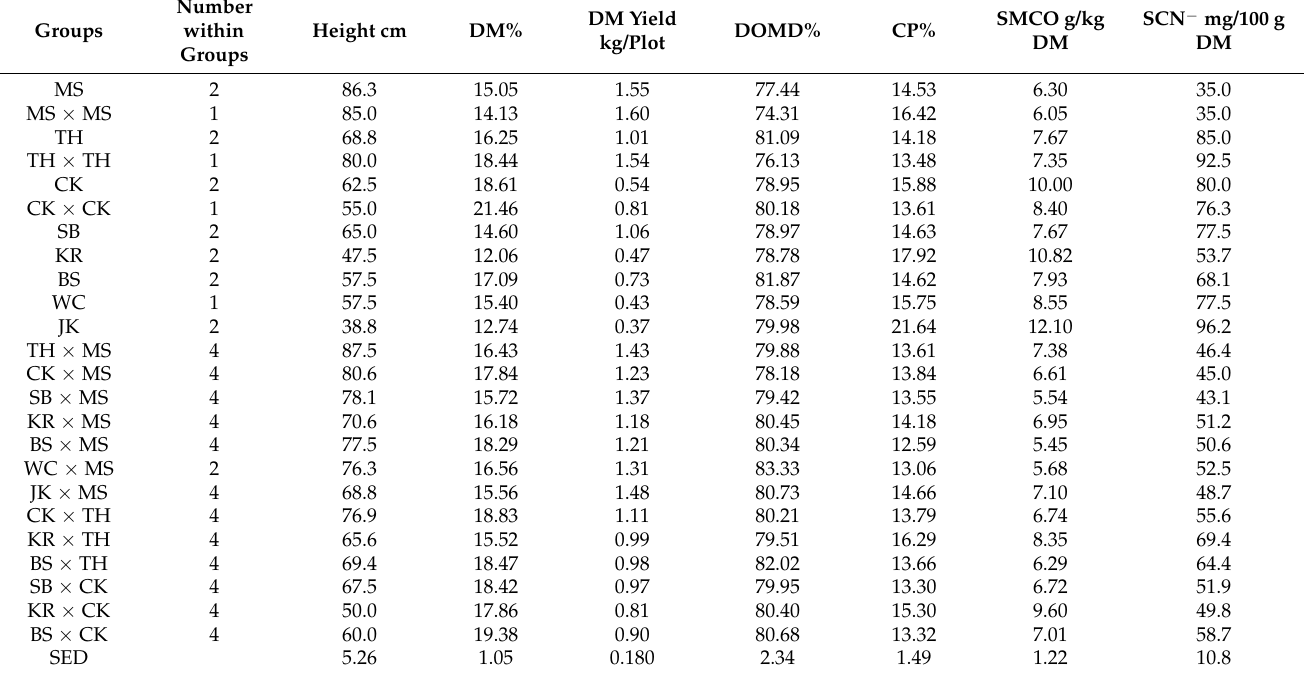
Table 2. Means for 21 groups (8 botanical varieties plus 13 hybrids) plus those for the hybrids between the two tall marrow-stem kales (MS × MS), the two dwarf thousand-head kales (TH × TH) and the two curled kales (CK × CK) where the SED is for comparing two groups of sizes 2 and 4 (most botanical varieties and